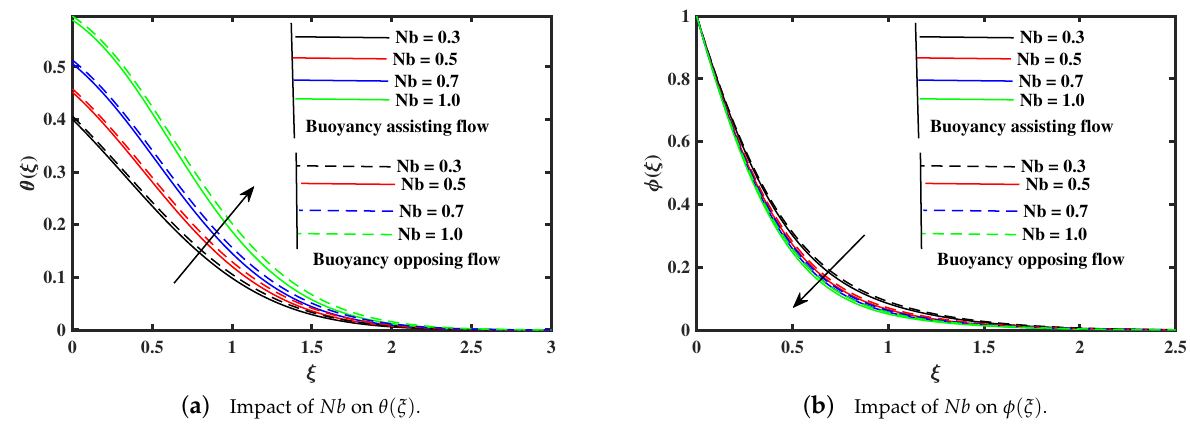
Figure 8. Fluctuation of θ ( ξ ) and φ ( ξ ) against Brownian motion ( Nb ).